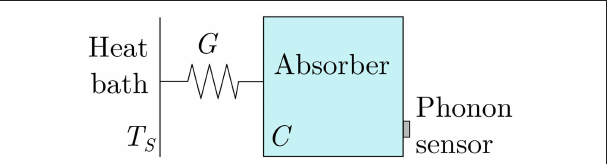
FIGURE 1 | Simplified bolometer thermal model. The detector is modeled as a single object with heat capacity C coupled to the heat sink (at constant temperature T S ) through the thermal conductance G . The phonon sensor plays no active